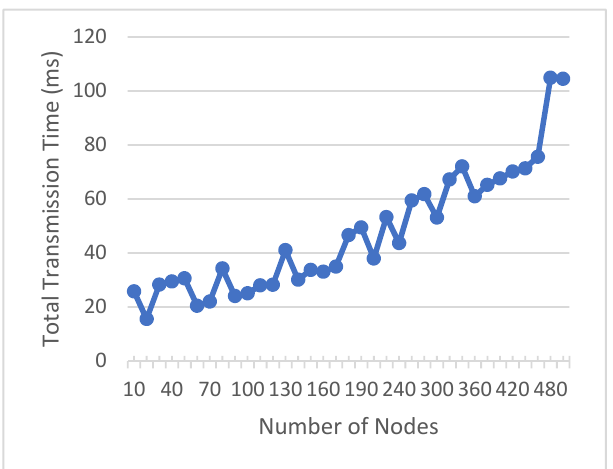
Figure 12. The total transmission time vs. the number of nodes in the LMF model.